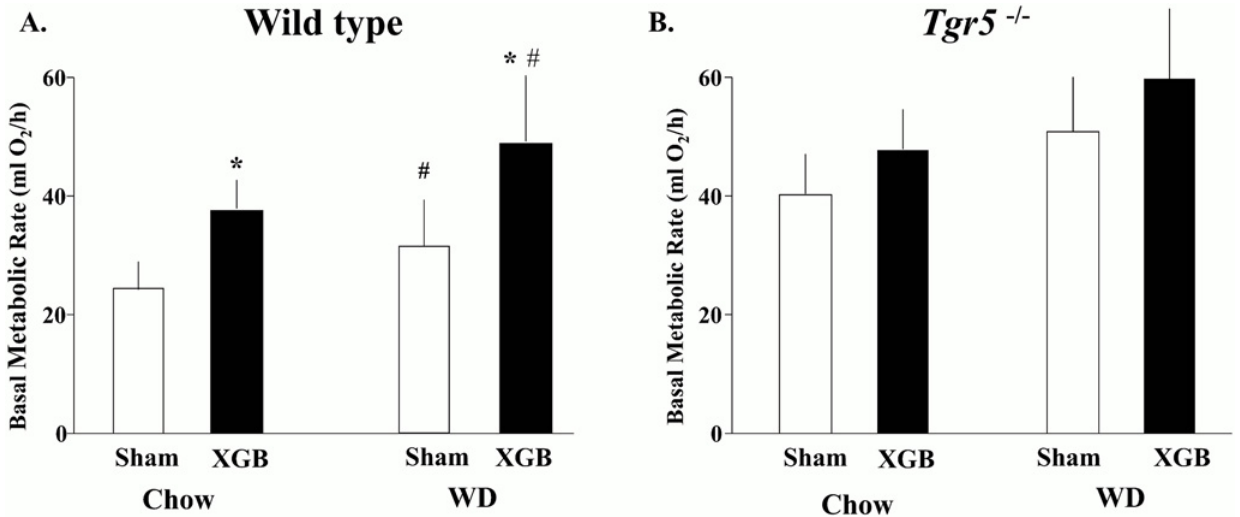
Fig 4. Effect of XGB on basal metabolic rate in wild type and Tgr5 -/- mice fed chow or WD diet. VO2 was measured during the dark and light phases of the diurnal cycle in thermoneutral conditions (18, 25). Panel A shows animals fed a control chow diet and panel B represents animals fed the WD. There were 5 to 6 mice per group. White bars represent sham — operated mice and black bars represent mice subjected to XGB. The experiment was independently repeated three times with equivalent results. Values represent the mean ± S.E.M. * p < 0.02 compared with the XGB mice; # p < 0.05 compared with the wild type animals (two-way